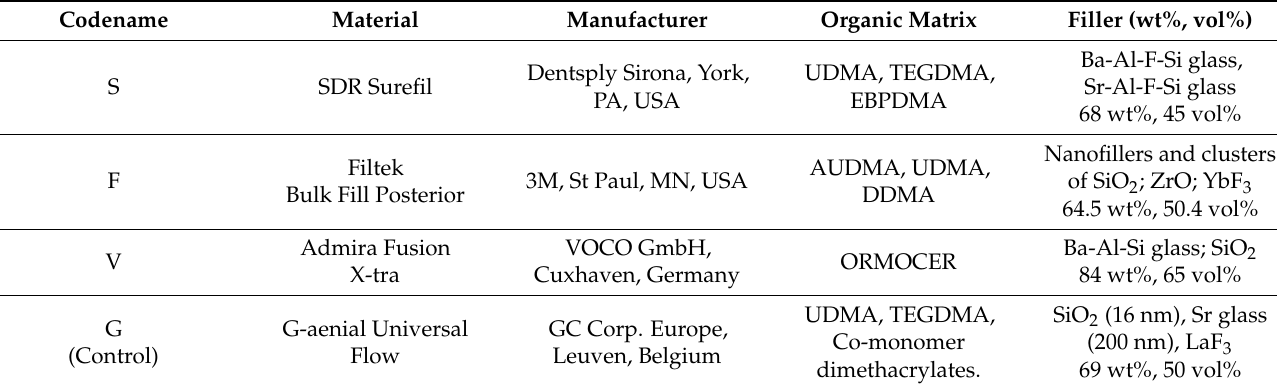
Table 1. Codename, manufacturer, and composition of the resin-based materials tested in the present